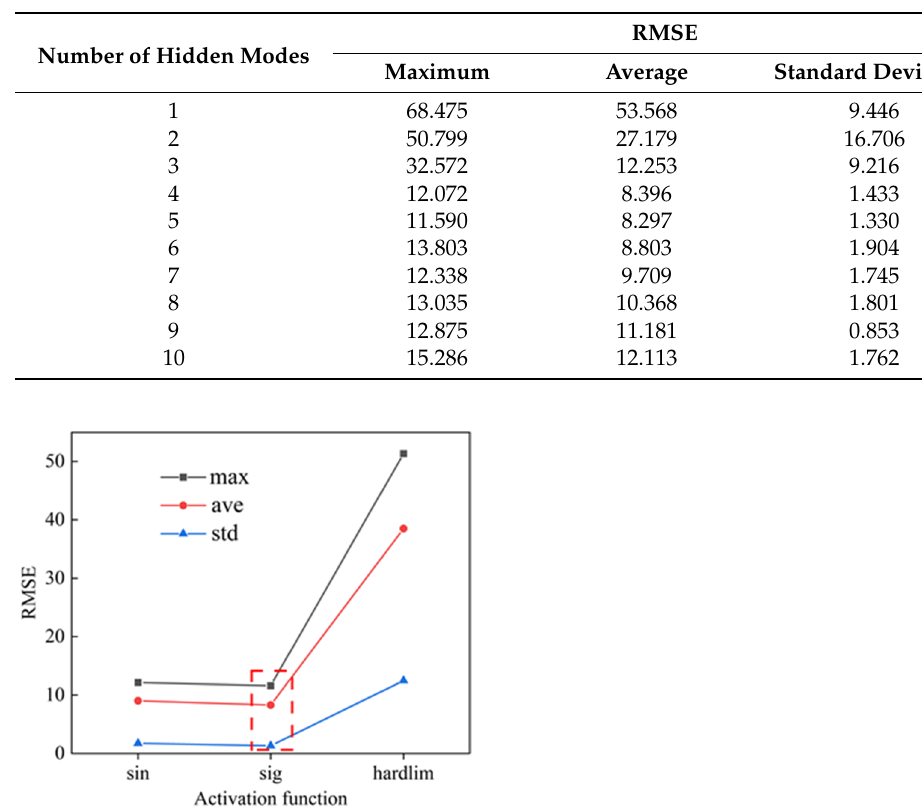
Table 2. Effects of the number of hidden modes on the ELM performance.